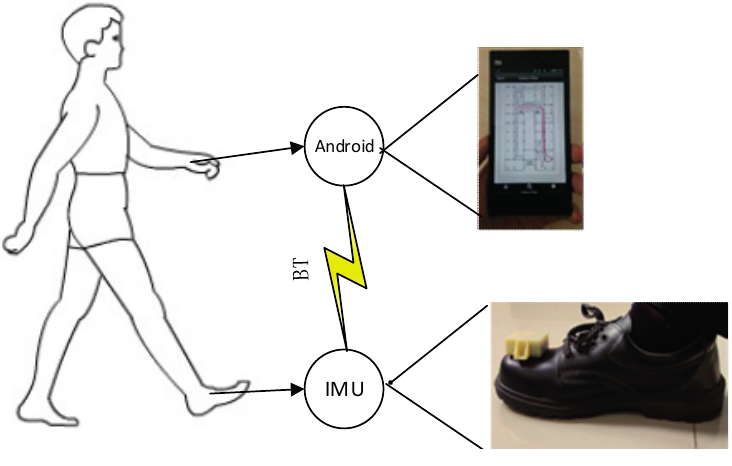
Figure 1. PINS application